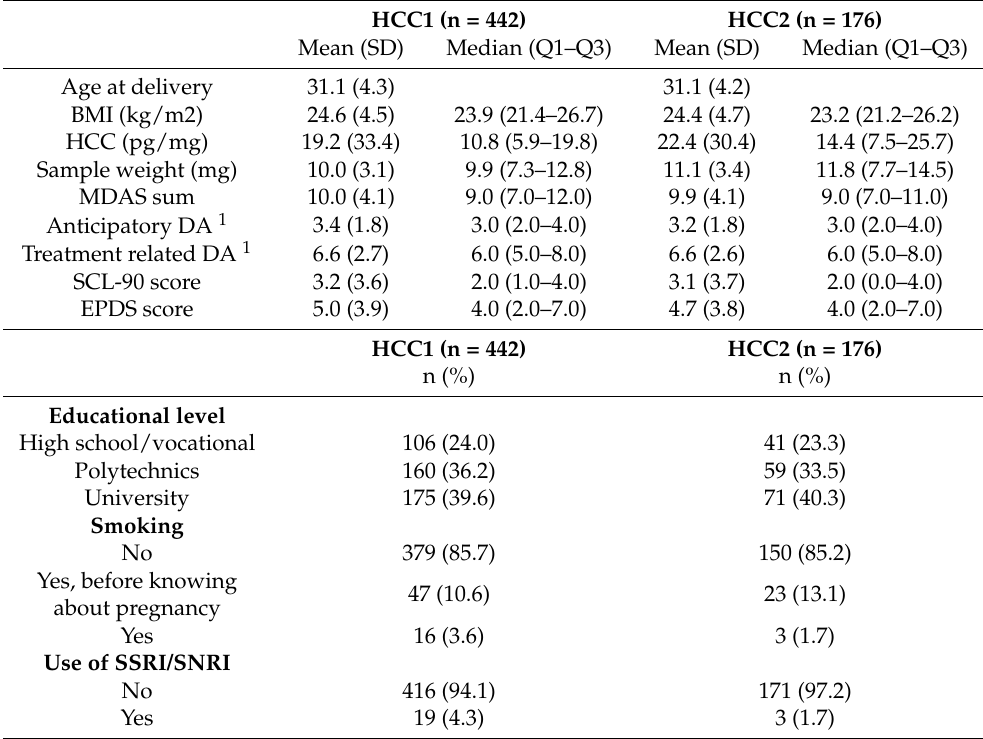
Table 1. Descriptive statistics of hair cortisol concentration measured at gwk 24 (HCC1) and at delivery (HCC2), MDAS and its factors, and potential covariates.